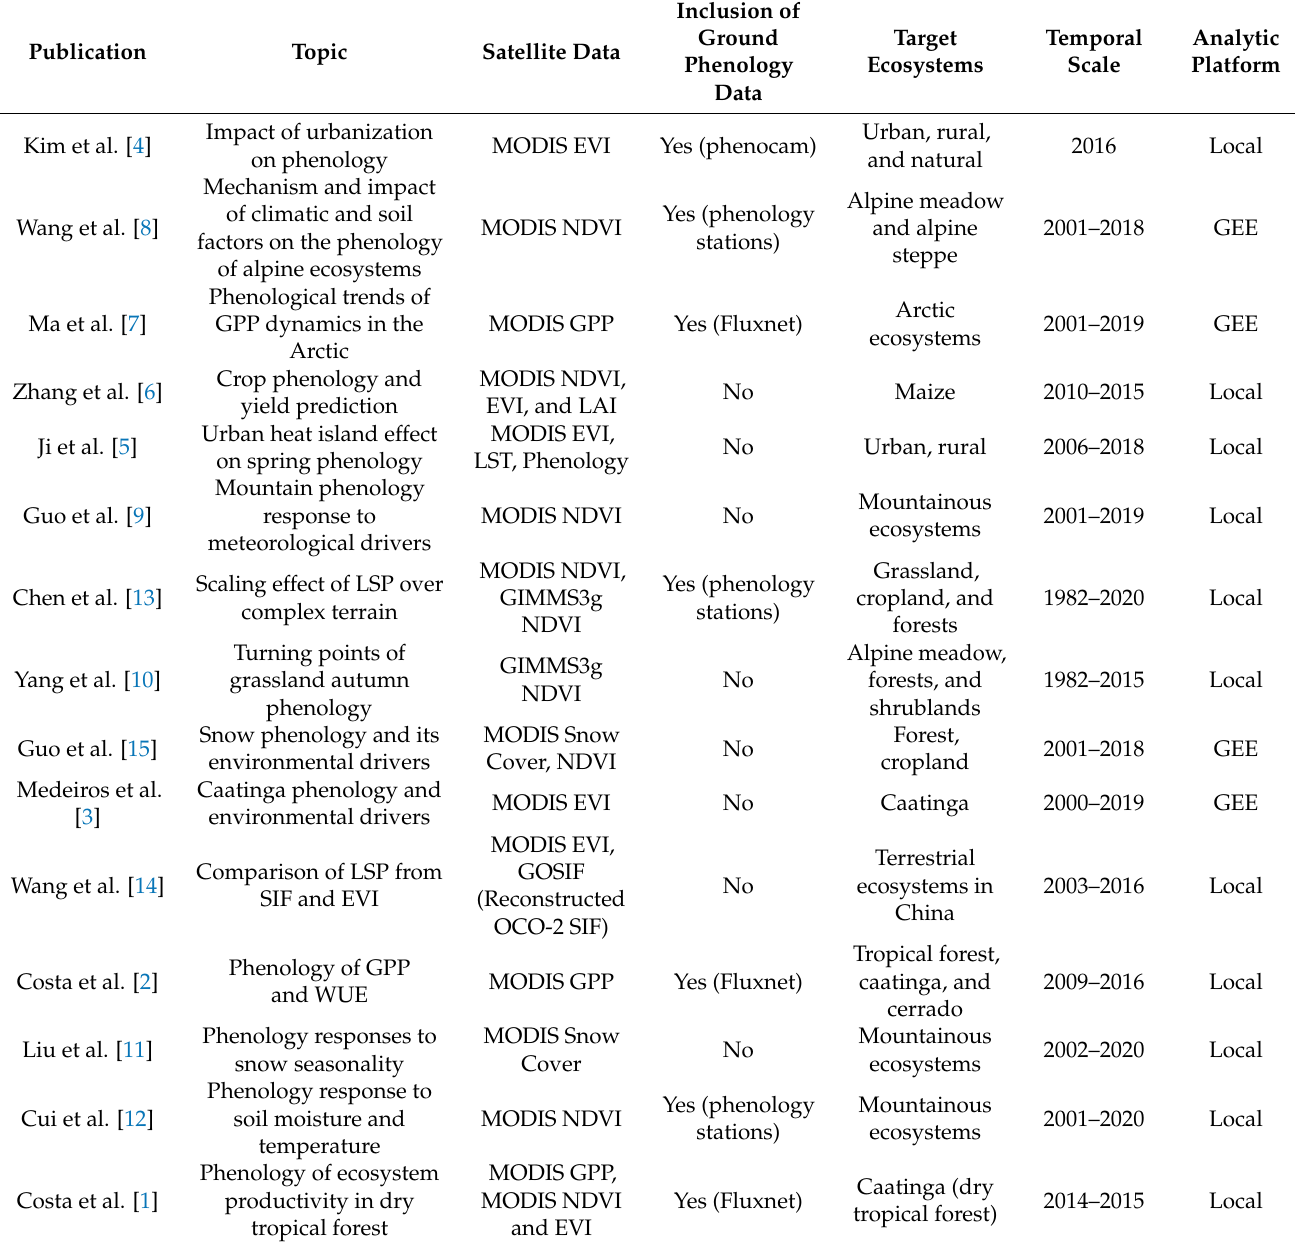
Table 1. Publication summary of the Special